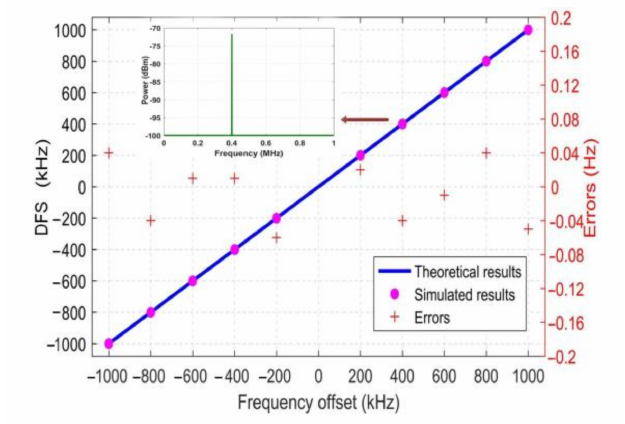
Figure 5. Measured different DFSs as the frequency offset of the echo signal from − 1 MHz to +1 MHz at intervals of 200 kHz and the corresponding errors for the frequency of the transmitted signal at 15 GHz.